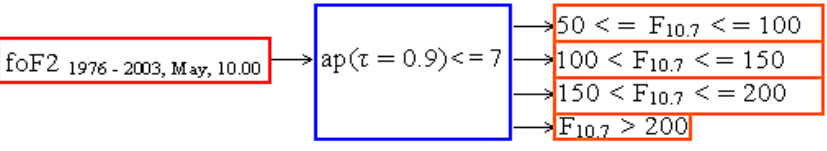
Fig. 1. Scheme followed to select data relative to quiet geomagnetic conditions for 4 different ranges of solar flux.